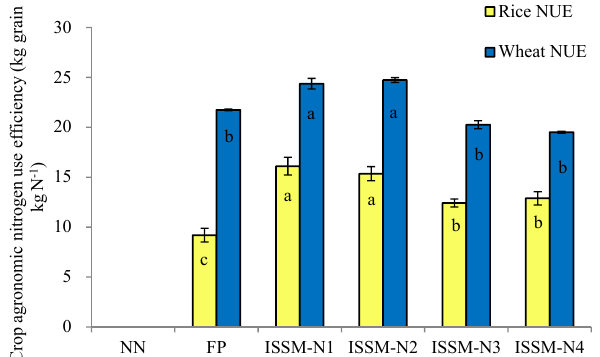
Figure 2. Rice and wheat agronomic nitrogen use efficiency (NUE) in 2011–2014 in Changshu, China. Different letters indicate a sig- nificant difference between treatments ( p <0.05). See Table 1 for treatment codes.